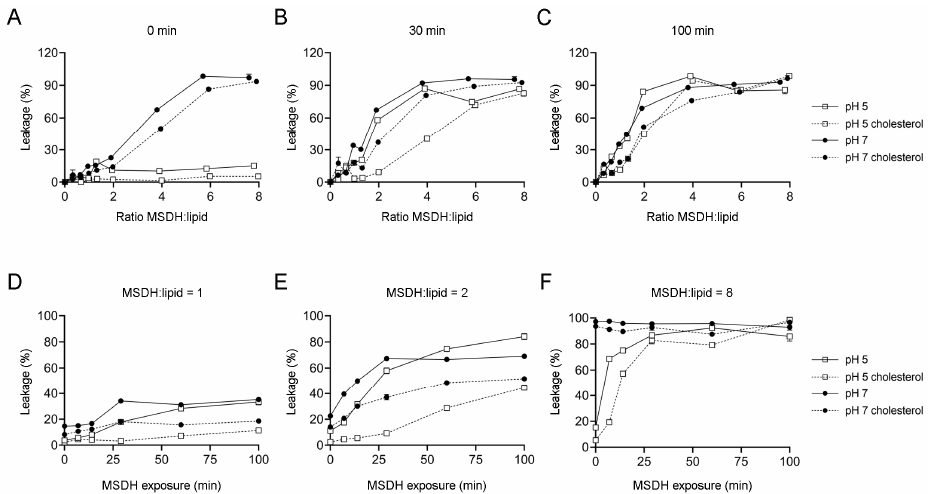
Figure 1. Leakage of small molecules from liposomes. The dye / quencher pair 8-aminonapthalene-1,3,6 trisulfonic acid / p-xylene-bis-pyridinium bromide (ANTS / DPX) (350 Da) was encapsulated in liposomes containing 40% or no cholesterol. Liposomes were mixed with increasing concentrations of O-methyl-serine dodecylamine hydrochloride (MSDH) and ANTS leakage was analyzed ( A ) immediately, ( B ) 30 min and ( C ) 100 min after adding MSDH at pH 7 or pH 5. Analysis of time dependent leakage of ANTS from liposomes with estimated MSDH / lipid ratios of ( D ) one, ( E ) two and ( F ) eight. In total, 100% leakage corresponds to samples exposed to Triton X-100. The results are shown as mean ± SD, n > 3. Most errors are smaller than the size of the